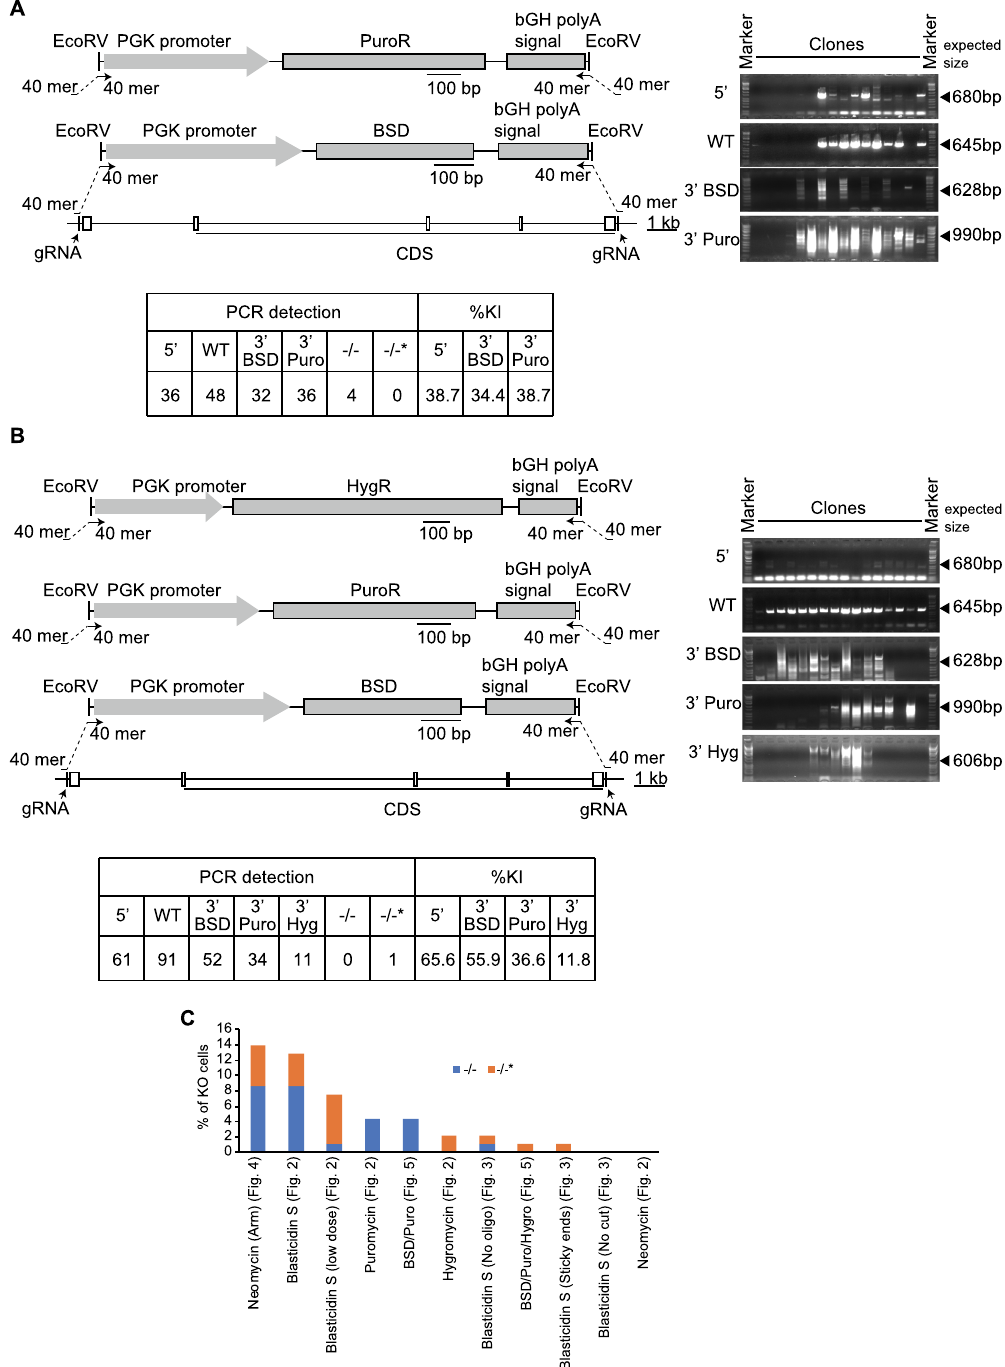
Figure 5. Multiple selection markers did not increase the efficiency to obtain KO clones. ( A , B ) The schemas of knockout of the target gene by pX330 plasmids, ssODNs, and the cassette with PuroR and BSD as selection markers ( A ) or with HygR, PuroR, and BSD as selection markers ( B ). The concentration of antibiotics for selection is 100 µg/mL BSD and 5 µg/mL Puromycin ( A ) or 100 µg/mL BSD, 5 µg/mL Puromycin, and 400 µg/ mL Hygromycin ( B ). Agarose gel images show the genotyping results. The table indicates the genotyping results of 93 clones. BSD, blasticidin S resistant gene; HygR, hygromycin resistant gene; PuroR, puromycin resistant gene; ssODNs, single-strand oligodeoxynucleotides. 5 ′ , 5 ′ site between the genomic region and the cassette; 3 ′ , 3 ′ site between the genomic region and the cassette; WT, wild-type allele; −/−, homozygously knockout clones: −/−*, homozygously knockout clones without the detection of 5 ′ or 3 ′ sites ligation between the genomic region and the cassette; %KI, percentage of knock-in in 93 clones. ( C ) Bar graph of KO percentage comparing different approaches in this